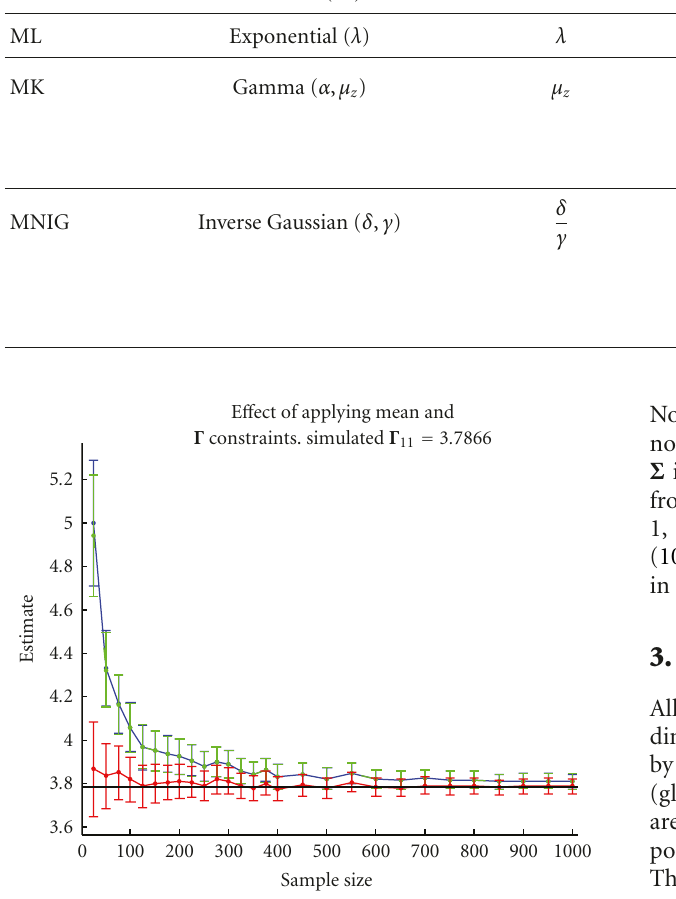
Figure 2: E ff ect of constraints on Γ 11 estimate versus sample size: Unconstrained in blue, zero-mean constraint in green, and covariance constraints in red. Note that the green points completely overprint the blue above size